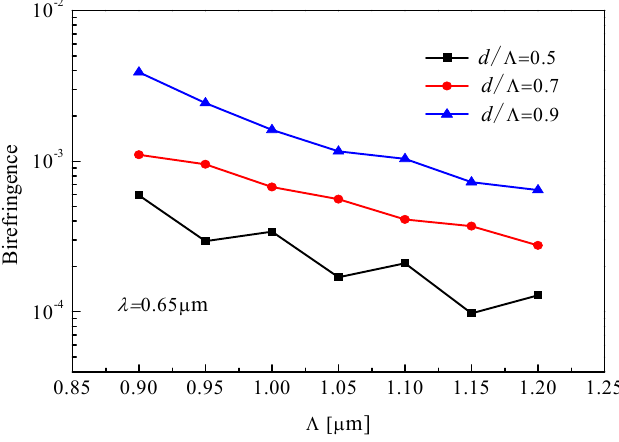
Figure 3. Period Λ dependence of the birefringence for different air-filling ratio d /Λ.